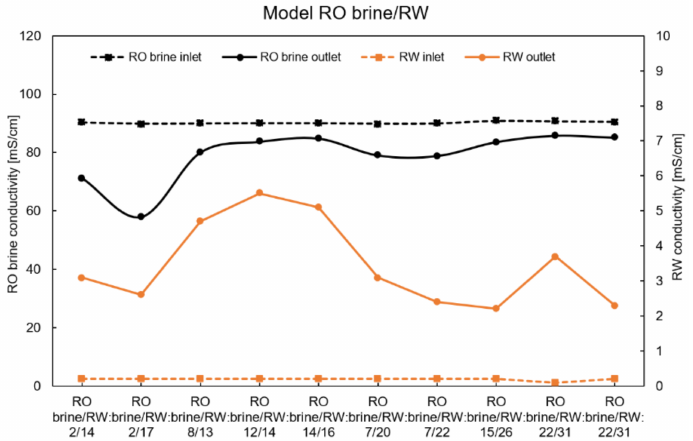
Figure A2. Conductivity of inlet and outlet solutions using the model RO brine/RW at zero current.